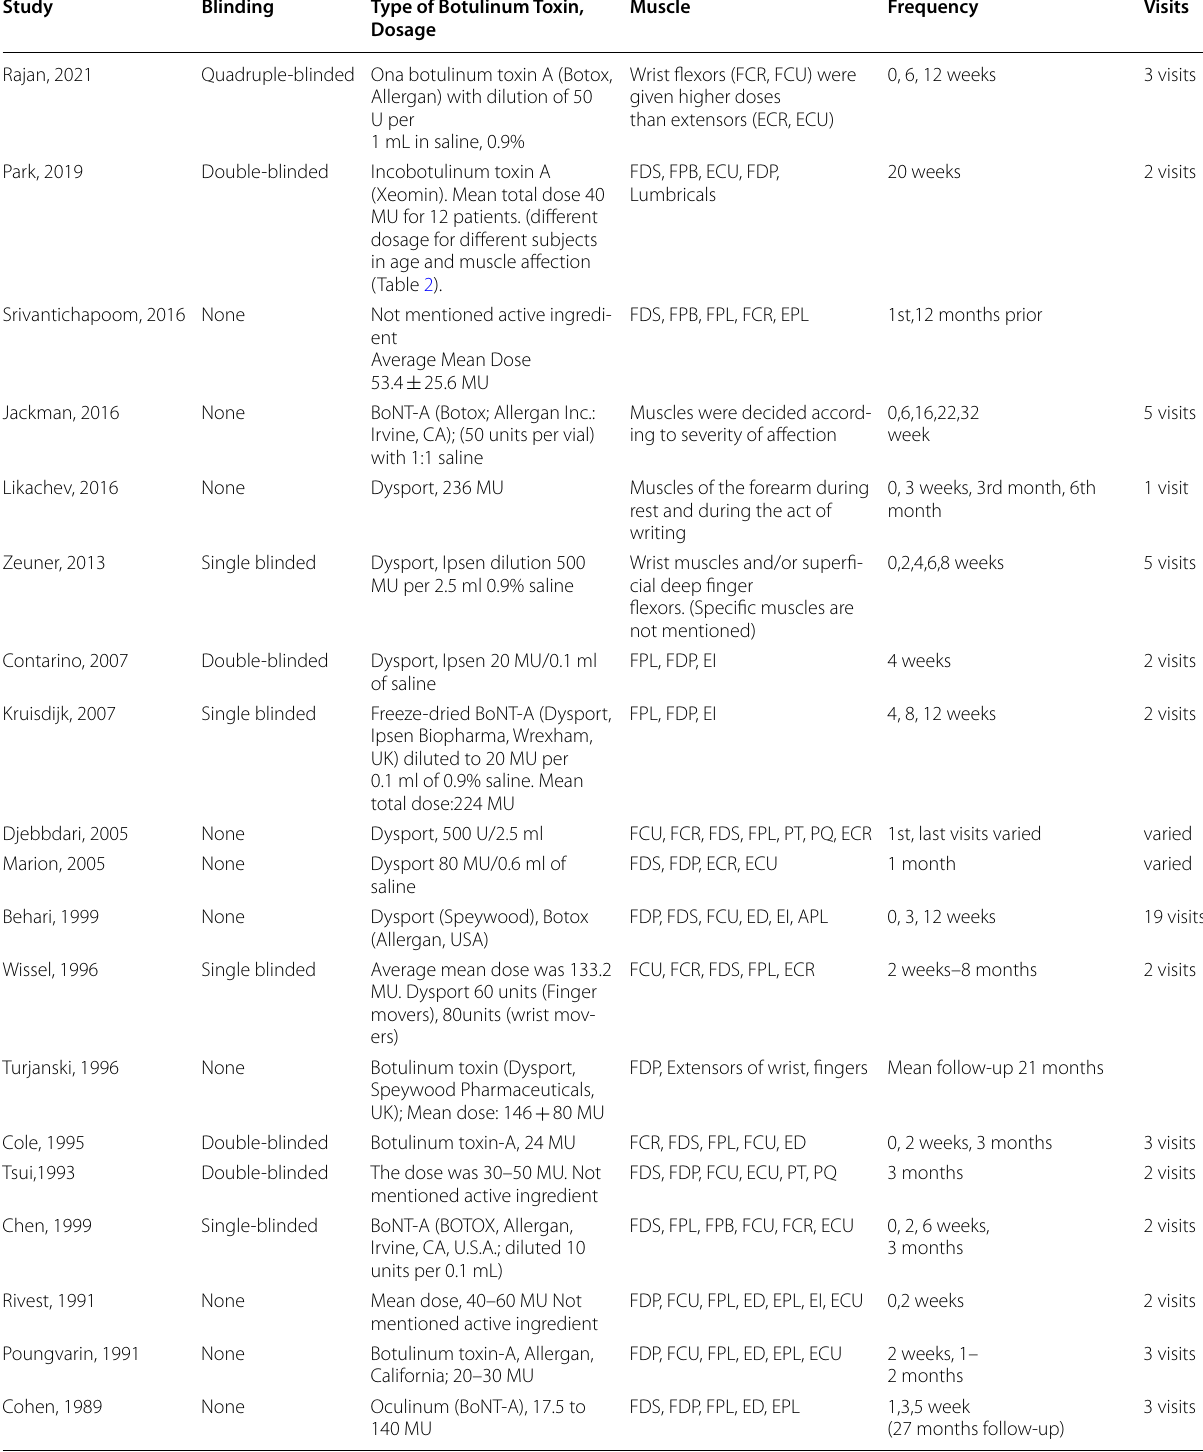
Table 3 Botulinum toxin injection